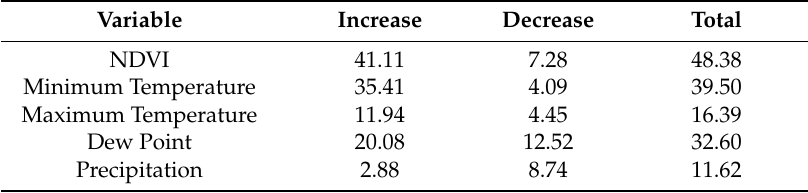
Table 2. Percent of total pixels with significant increasing or decreasing trend in the univariate analyses for the NDVI and for each of the climatic factors. Significance level is p <